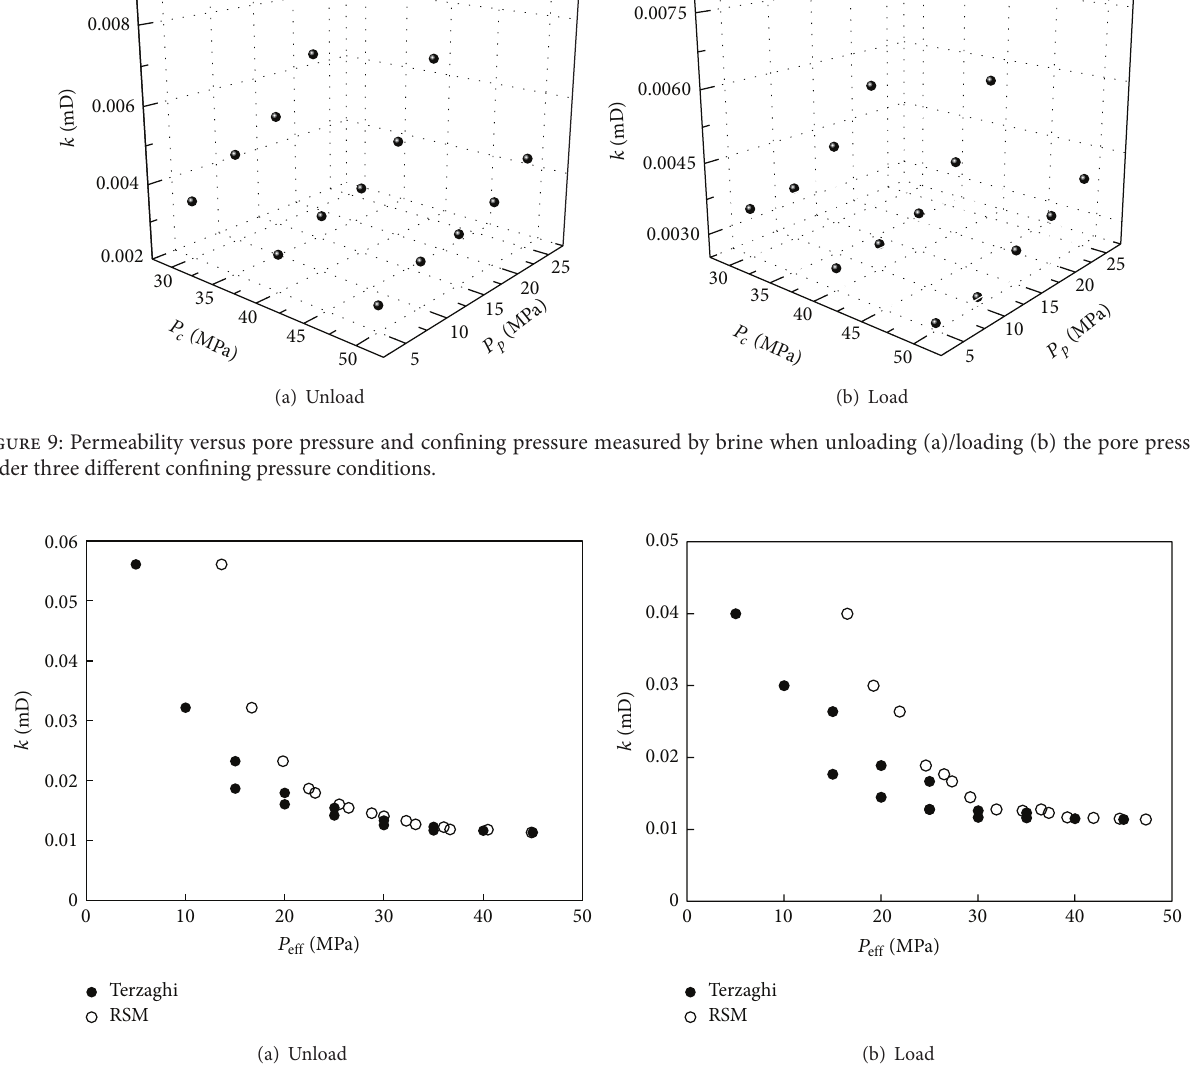
Figure 10: Permeability versus effective pressure under nitrogen condition during pore pressure unloading (a)/loading (b)